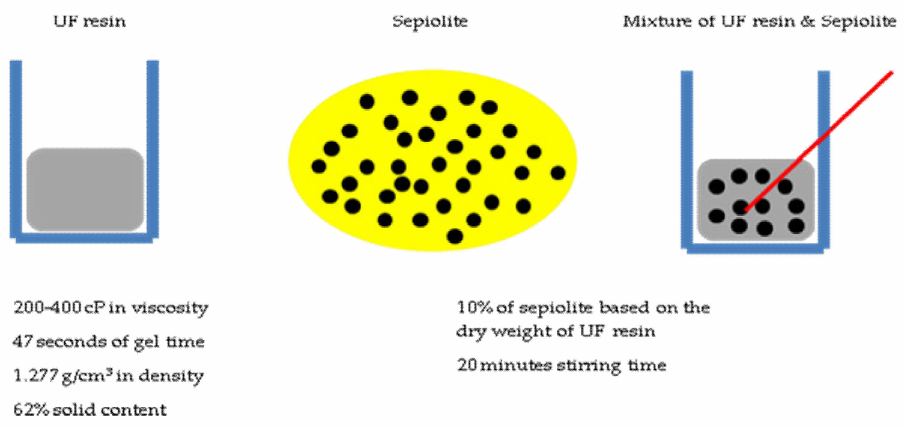
Figure 1. Flow diagram of resin–sepiolite mixture